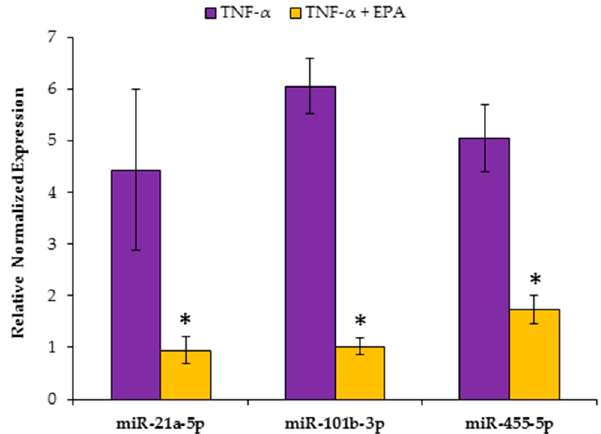
Figure 9. Eicosapentaenoic acid (EPA) alters miRNA expression in treated HepG2 cells. miR-21a-5p, -101b-3p, and -455-5p were significantly reduced with EPA in TNF- α stimulated HepG2 cells. Data are expressed as mean ± SEM, n = 4–6, * = p <0.05.